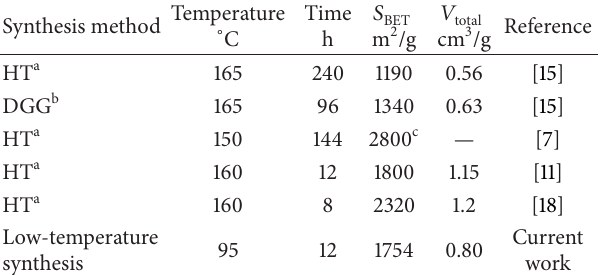
Table 1: Synthesis conditions and textural properties of MIL- adsorption at − 196 ∘ C in comparison with 100(Fe) measured by N 2 other